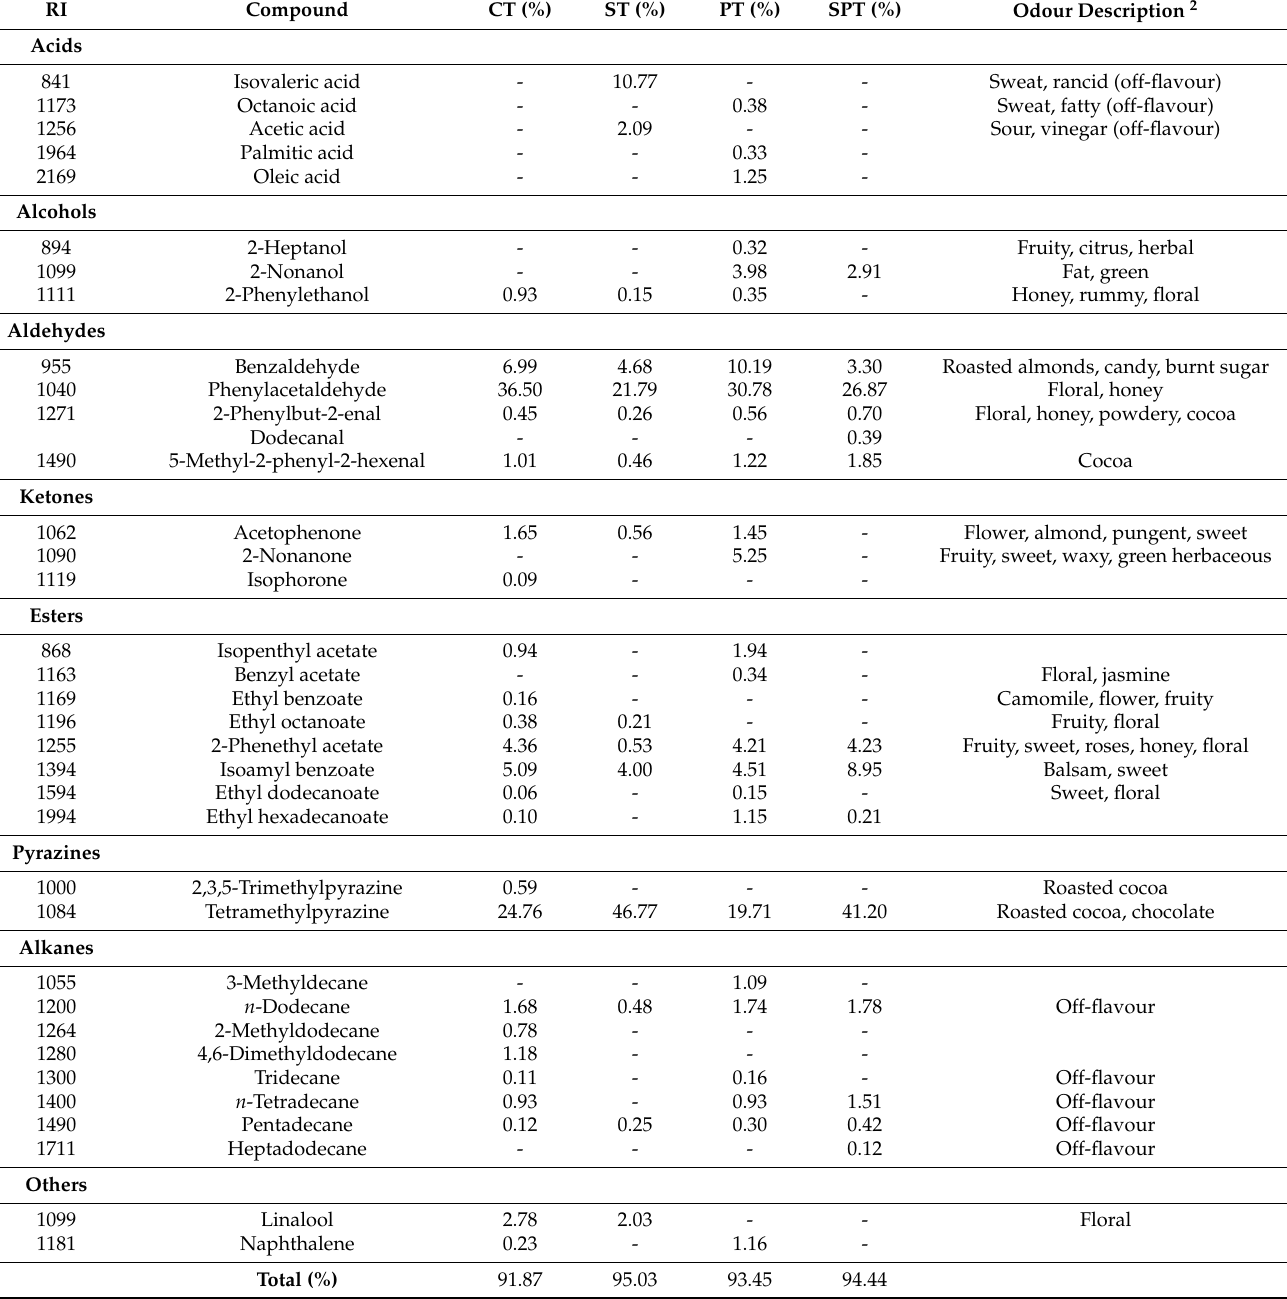
vinegar and rancidity to the quality of chocolate as a final product. The production of these compounds is also related to the performance of bacteria of the genus Bacillus sp. at the end of the fermentation process [5,27,28]. The ST treatment showed a higher acid content, with isovaleric acid responsible for 10.77% and acetic 2.09%. On the other hand, the PT treatment presented a greater variety of acidic compounds: octanoic, palmitic and oleic. Table 2. Volatile compounds (GC-MS) in fermented and dried cocoa beans with the addition of three different yeast starter cultures 1 .